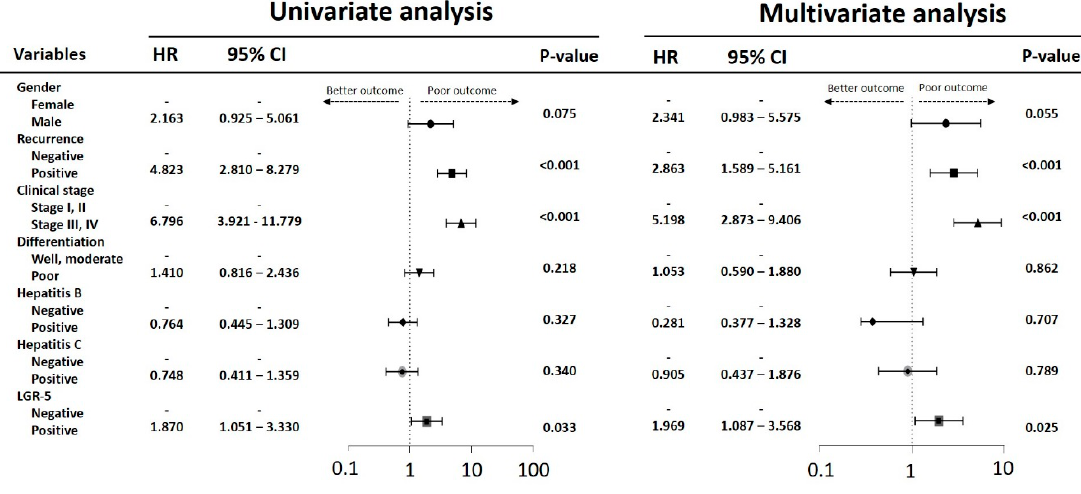
Figure 4. Univariate and multivariate analysis of influence of clinical characteristics in HCC patients.